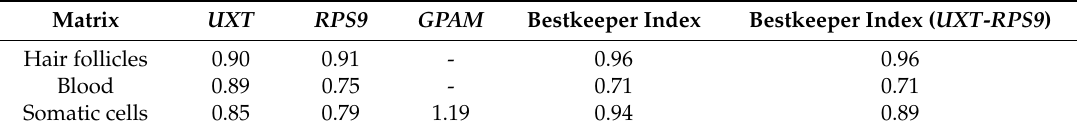
Standard deviation of crossing-point (CP) values obtained for the three reference candidates—ubiquitously expressed prefoldin-like chaperone ( UXT ), ribosomal protein S9 ( RPS9 ), and mitochondrial glycerol 3-phosphate acyltransferase ( GPAM ). For hair follicles and blood,